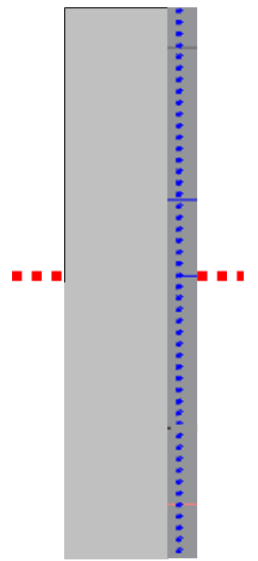
Figure 20. Typical cross-section of the pipe with prestressing wires.